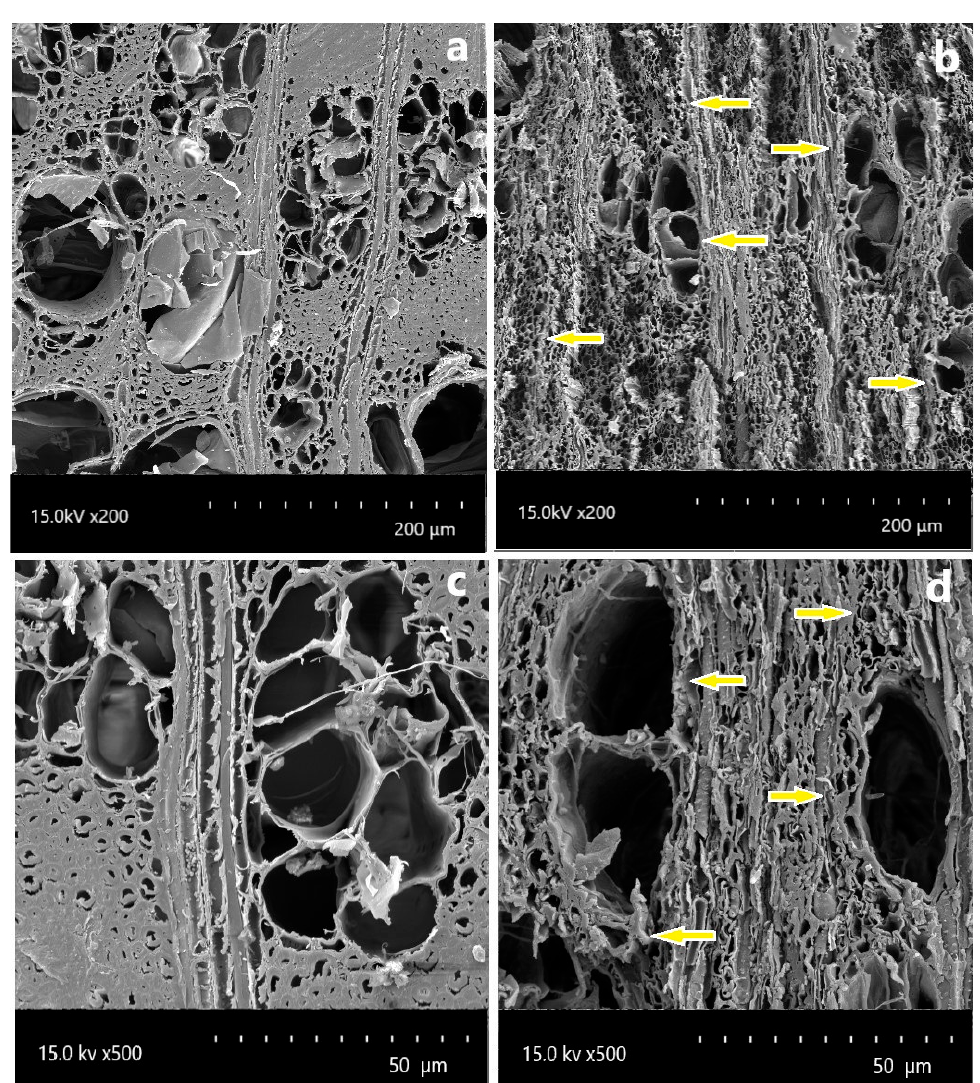
Figure 6. Scanning electron microscopy (SEM) micrographs of fresh and archaeological elm at 200 μ m ( a and b ), and 50 μ m ( c and d ) magnification. Arrows indicate the damaged parts of AW.